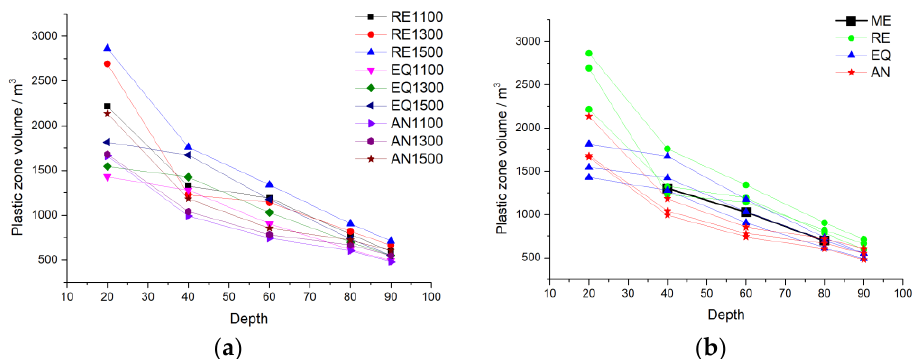
Figure 13. ( a ) Comparison between results of two methods and measured values; ( b ) Comparison between measurement and calculation.